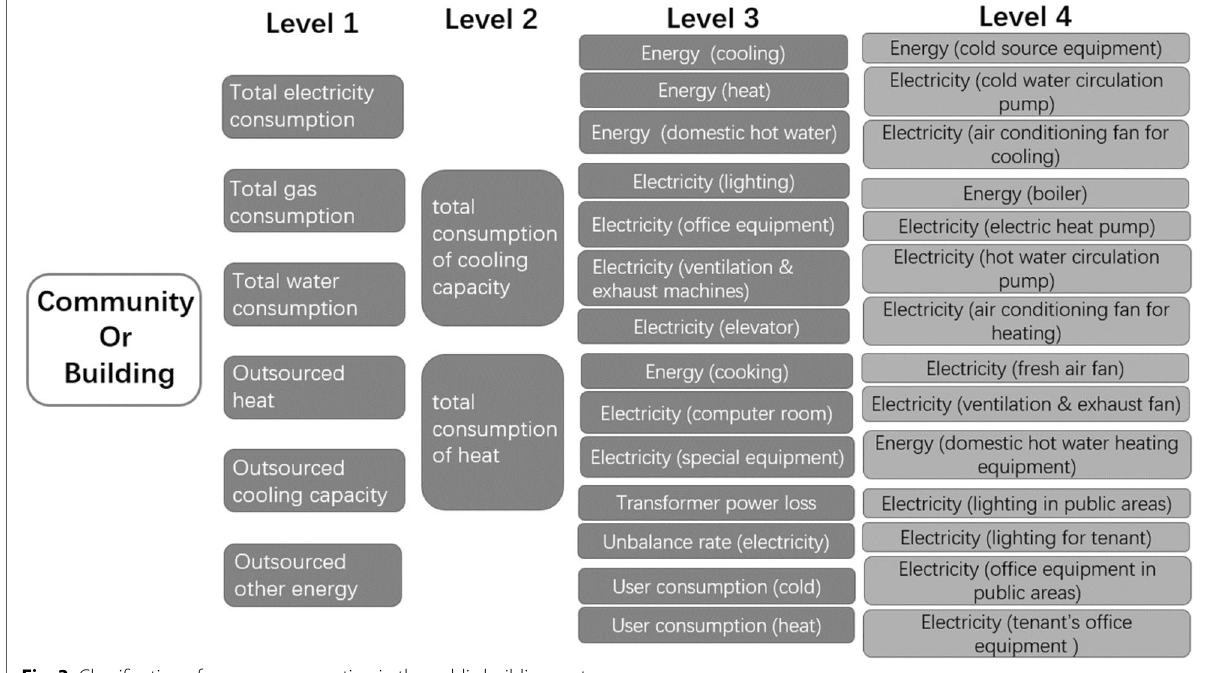
Fig. 3 Classification of energy consumption in the public building